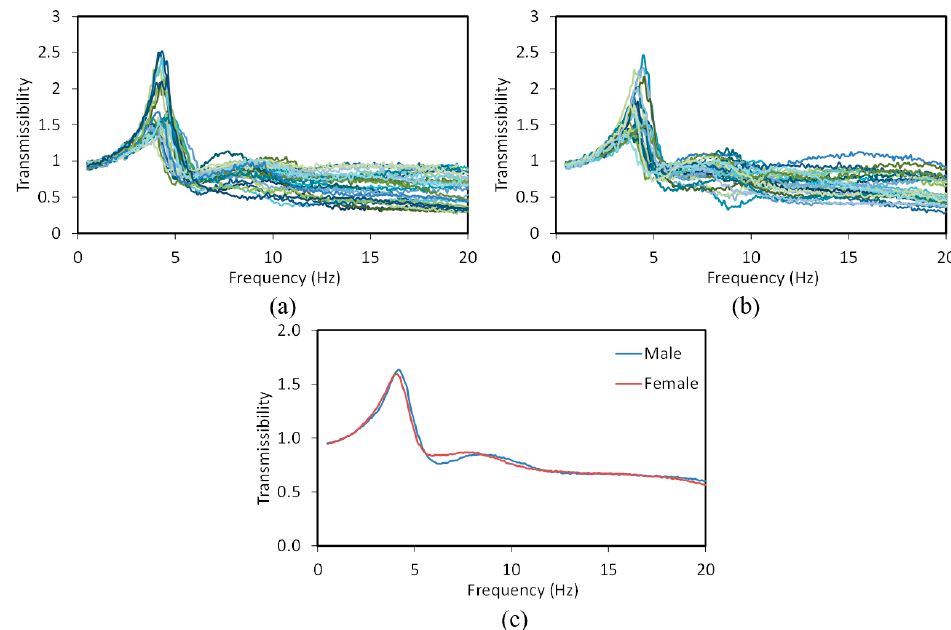
Figure 2. Acceleration transmissibility of the seat with 31 males and 27 females under 0.50 m/s 2 vertical vibration at the body–seat interface: ( a ) male subjects; ( b ) female subjects; and ( c ) mean (without back support).